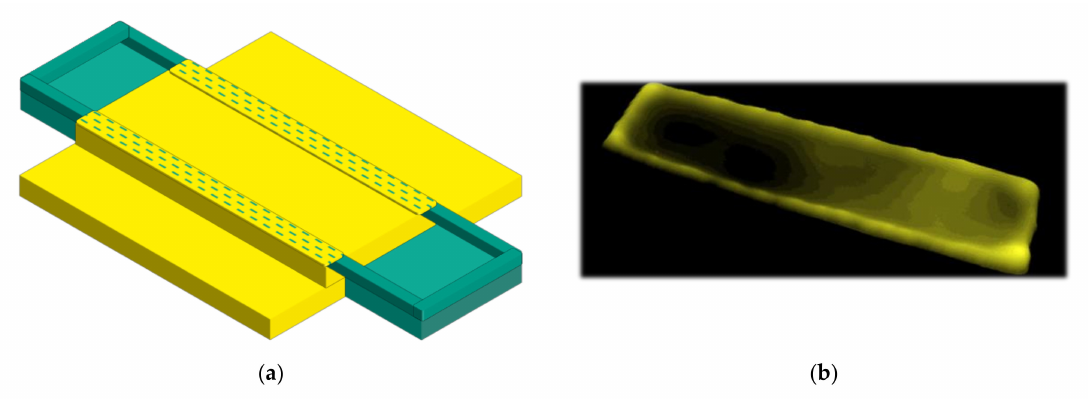
Figure 2. ( a ) Schematic representation of a printed composite layer on a silver electrode, which has a thick edge area. The dashed area of the composite layer represents the thinnest part, which is susceptible to cracking; ( b ) 3D-topography of a printed silver electrode on PET, with the intended thick edge area.